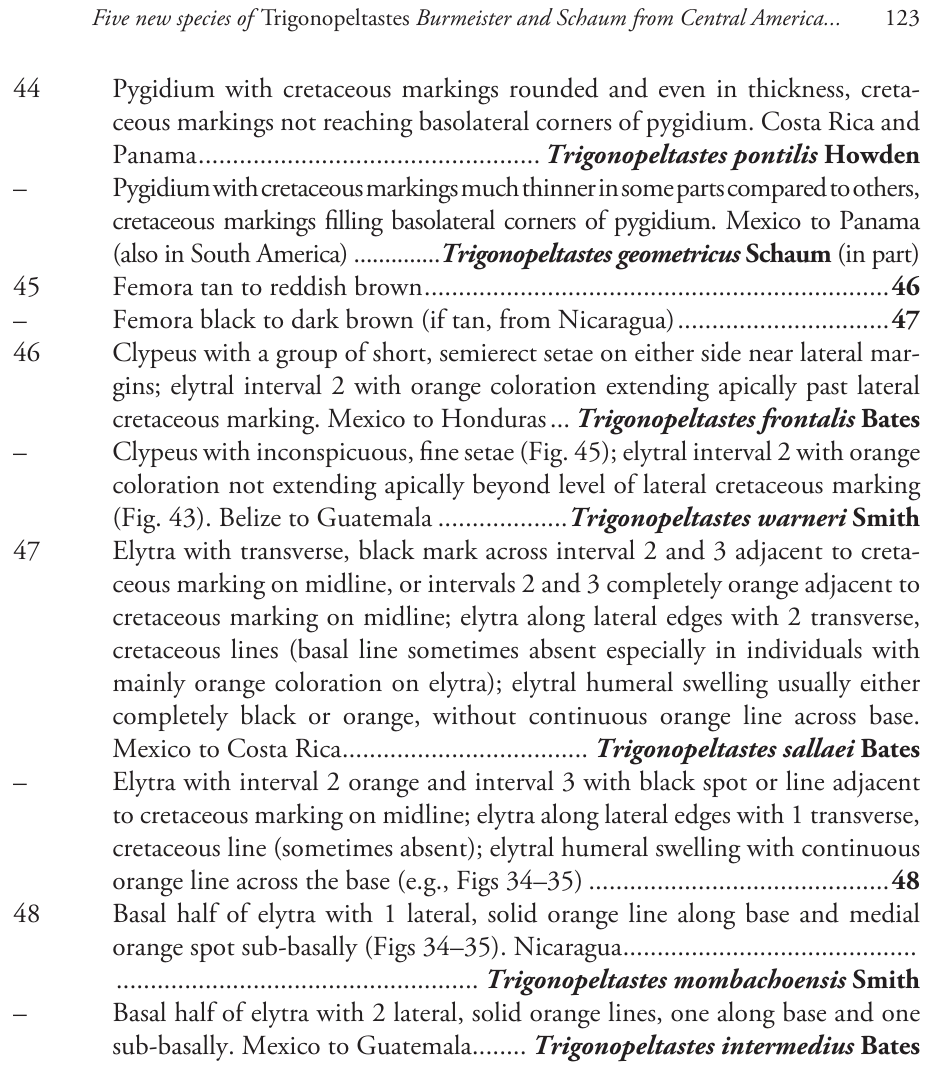
Panama .................................................. Trigonopeltastes pontilis Howden – Pygidium with cretaceous markings much thinner in some parts compared to others, cretaceous markings filling basolateral corners of pygidium. Mexico to Panama (also in South America) .............. Trigonopeltastes geometricus Schaum (in part) 45 Femora tan to reddish brown .................................................................... 46 – Femora black to dark brown (if tan, from Nicaragua) ............................... 47 46 Clypeus with a group of short, semierect setae on either side near lateral mar- gins; elytral interval 2 with orange coloration extending apically past lateral cretaceous marking. Mexico to Honduras ... Trigonopeltastes frontalis Bates – Clypeus with inconspicuous, fine setae (Fig. 45); elytral interval 2 with orange coloration not extending apically beyond level of lateral cretaceous marking (Fig. 43). Belize to Guatemala ................... Trigonopeltastes warneri Smith 47 Elytra with transverse, black mark across interval 2 and 3 adjacent to creta- ceous marking on midline, or intervals 2 and 3 completely orange adjacent to cretaceous marking on midline; elytra along lateral edges with 2 transverse, cretaceous lines (basal line sometimes absent especially in individuals with mainly orange coloration on elytra); elytral humeral swelling usually either completely black or orange, without continuous orange line across base. Mexico to Costa Rica .................................... Trigonopeltastes sallaei Bates – Elytra with interval 2 orange and interval 3 with black spot or line adjacent to cretaceous marking on midline; elytra along lateral edges with 1 transverse, cretaceous line (sometimes absent); elytral humeral swelling with continuous orange line across the base (e.g., Figs 34–35) ............................................ 48 48 Basal half of elytra with 1 lateral, solid orange line along base and medial orange spot sub-basally (Figs 34–35). Nicaragua ........................................... ..................................................... Trigonopeltastes mombachoensis Smith – Basal half of elytra with 2 lateral, solid orange lines, one along base and one sub-basally. Mexico to Guatemala ........ Trigonopeltastes intermedius Bates